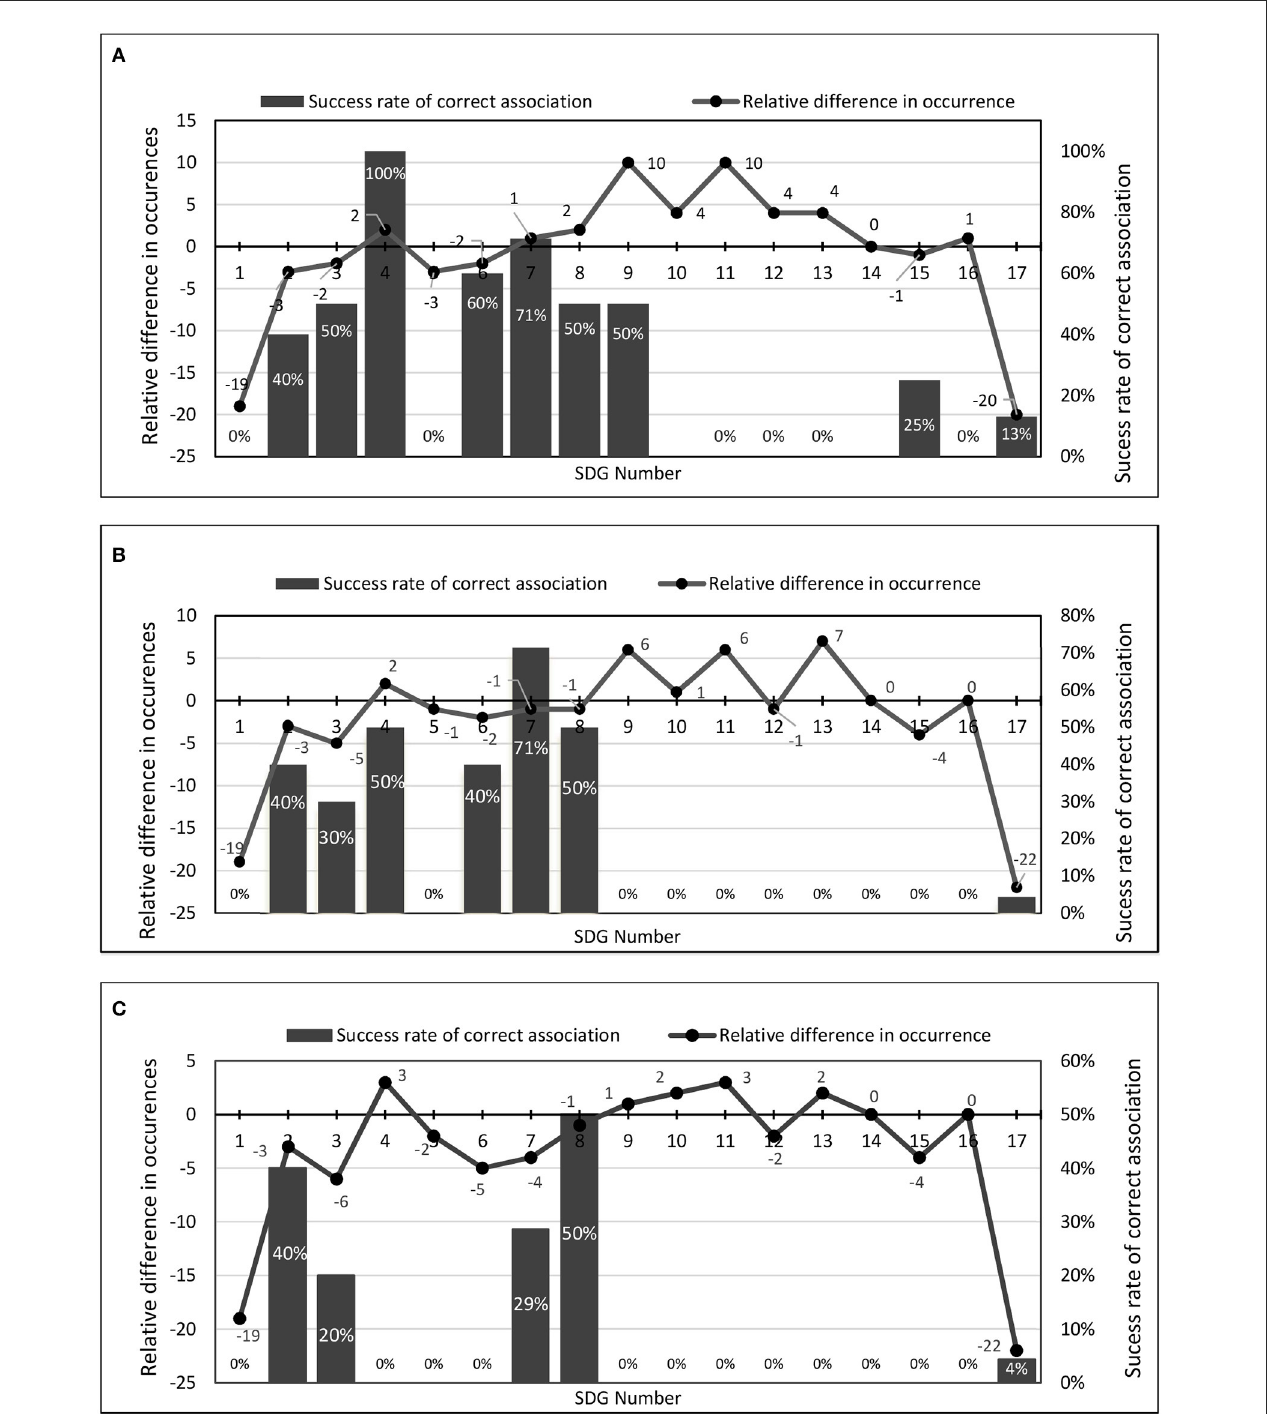
FIGURE4 SDG association success-rate and relative differences in SDG occurrences between the manual and computational modules/course associations, in each stage of the manual review. (A) Relative difference and success rate for Stage 1. (B) Relative difference and success rate for Stage 2. (C) Relative difference and success rate for Stage